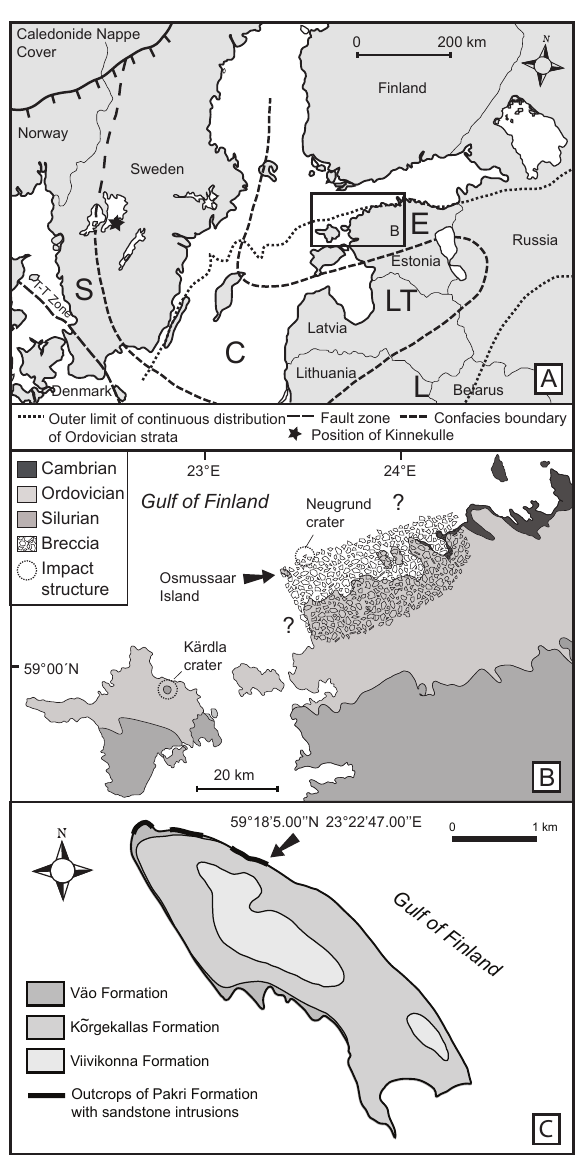
Fig. 1. A. Overview of the Baltoscandian region, after Jaanusson (1976, 1995) and Rasmussen et al. (2009). The rectangle indicates the area of Fig. 1B. Abbreviations: C = Central Baltoscandian Confacies Belt, E = North Estonian Confacies Belt, L = Lithuanian Confacies Belt, LT = Livonian Tongue, S = Scanian Confacies Belt. B. Close-up of northwestern Estonia showing the position of Osmussaar Island and the known distribution of the Osmussaar Breccia, after Alwmark et al. (2010). The question marks signify that the distribution of the breccia to the north and to the west is uncertain. C. Map of Osmussaar Island, showing the most widespread limestone formations as seen from above, and coastline outcrops where the breccia is exposed (thick black lines). The coordinates and arrow indicate the position of the sampling site. Modified from Suuroja et al.